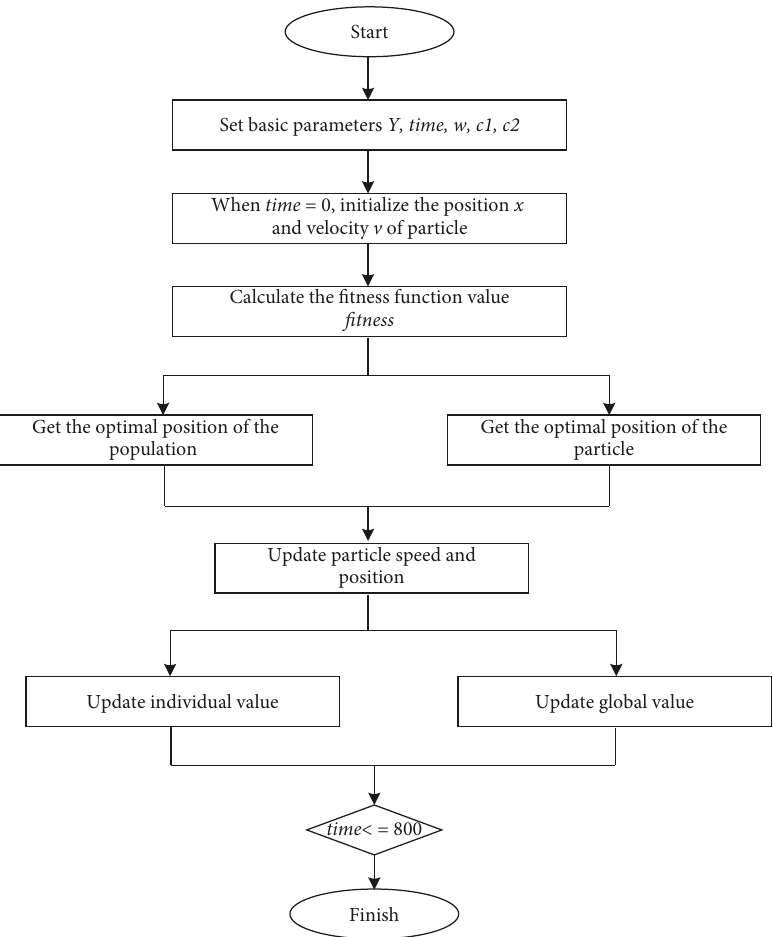
Figure 7: Flowchart for the PSO